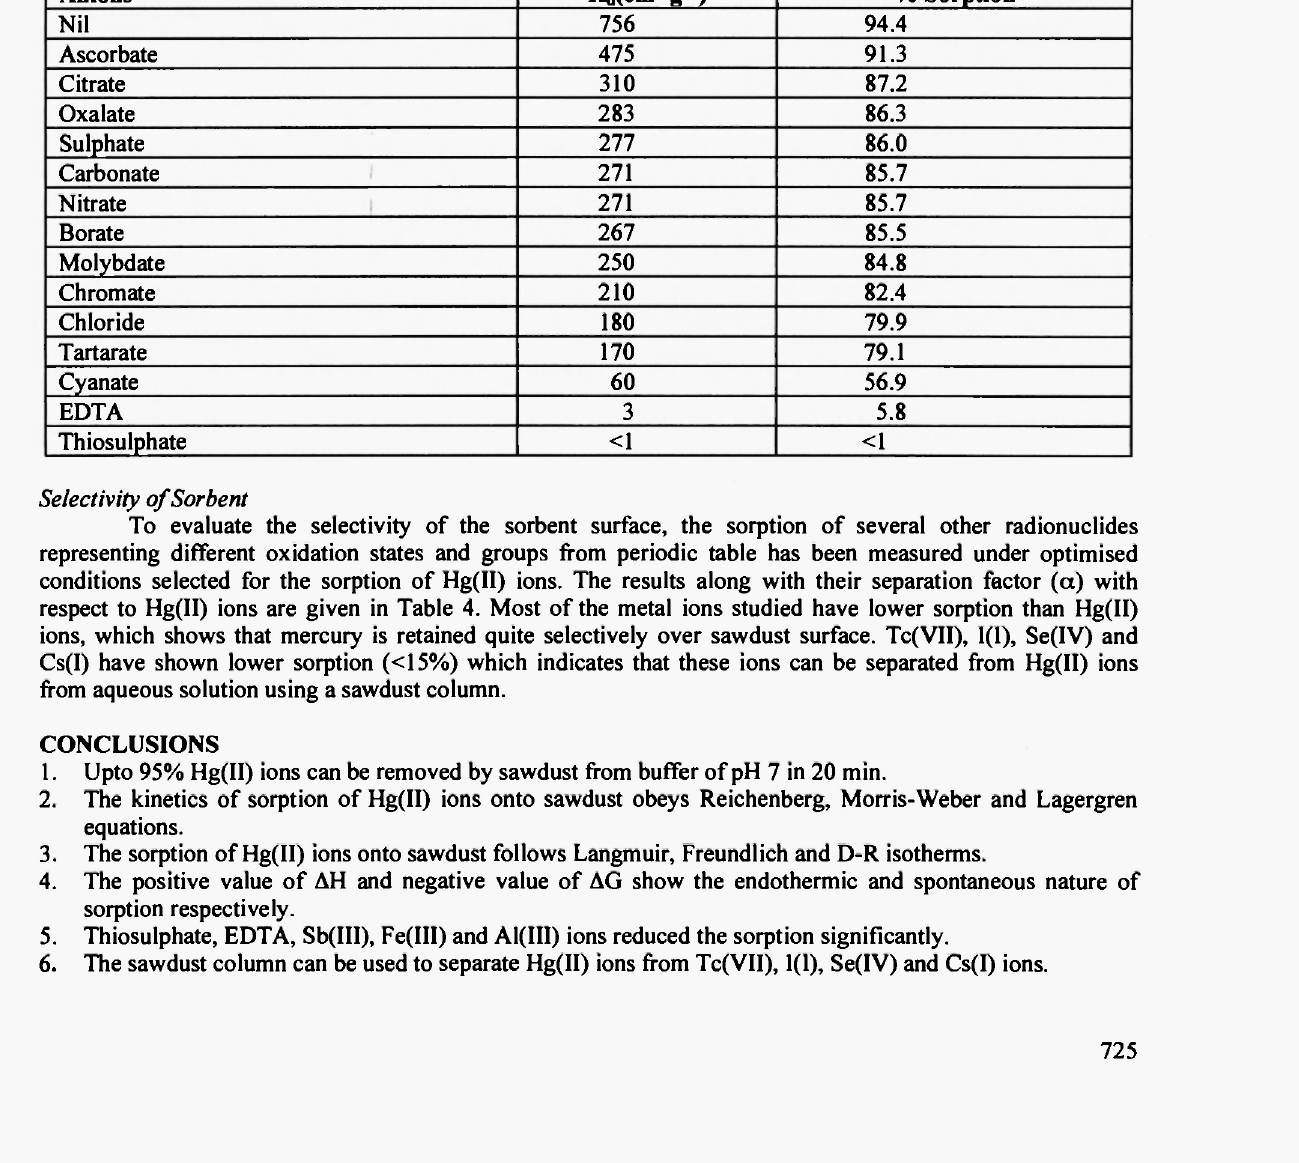
Table 2: Effect of anions on the sorption of Hg (II) ions (9.37x10" 6 !^) onto sawdust (100 mg) after 20 min agitation time from buffer solution of pH